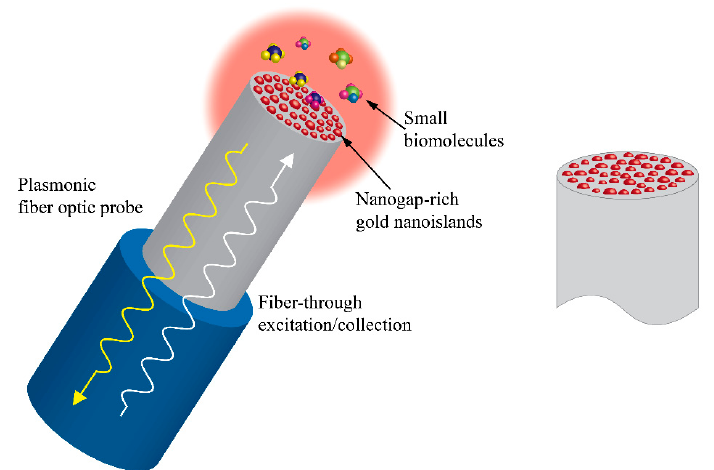
Figure 4. Fiber-optic plasmonic probe for surface-enhanced Raman scattering (SERS) with nanogap-rich Au nano-islands on the top surface of the fiber (modified from Kwak [33], free to read and use under the Creative Commons License).